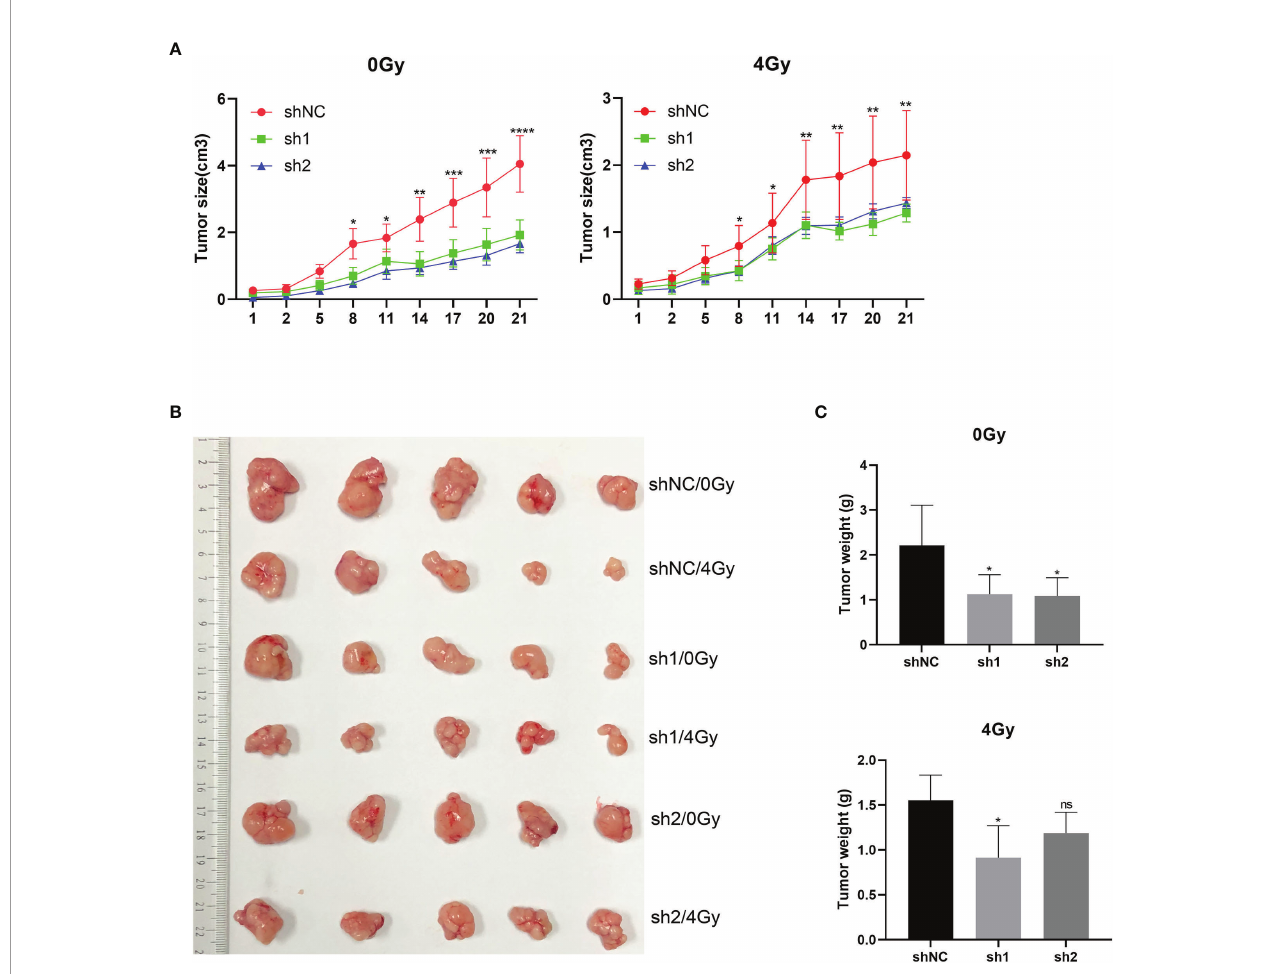
FIGURE 4 | In vivo experiments supported the effect of esophageal cancer on X-ray radiosensitivity after HuR downregulation. Four-week-old BALB/c nude mice were divided into three groups: (1) shNC group; (2) sh1 group; and (3) sh2 group (n = 5/group). (A) Tumor volume growth curve of each group. Two-dimensional measurements were taken with an electronic caliper, and the tumor volume in cm3 was calculated. (B) Representative subcutaneous tumors of each group. (C) Average of tumor weights for each group. ns >0.05, *p < 0.05, **p < 0.01, ***p < 0.001 and ****p <